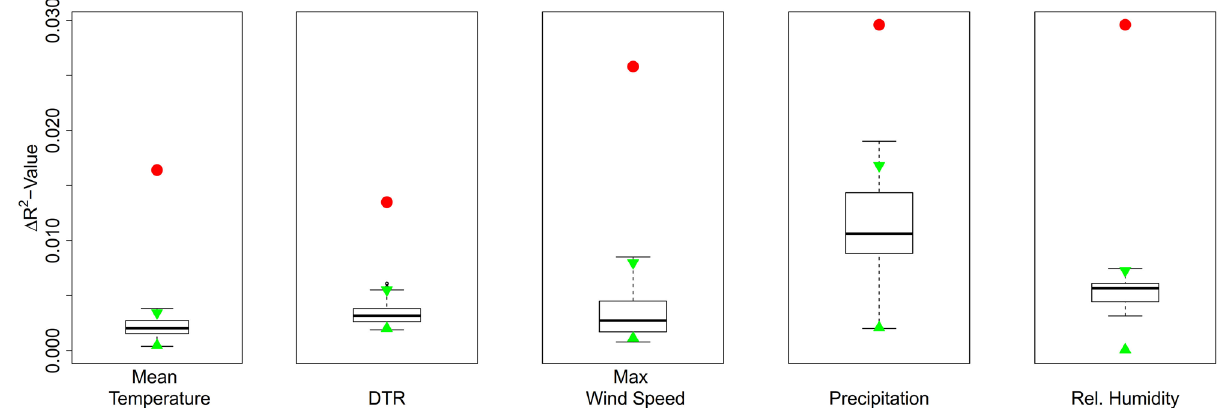
2 Figure 3. Permutation test representing the proportions of the variance ( (cid:31) R ) in the effective reproduction number explained by the true and 1000 null/dummy time series of respective significant drivers. The boxplot 2 represents the (cid:31) R from 1000 null/dummy time series generated by permutation on the years, and the stand- 2 alone red points are indicating (cid:31) R by true time series of the drivers. The green triangles show the 95% CI of (cid:31) R 2 evaluated by these 1000 null/dummy time